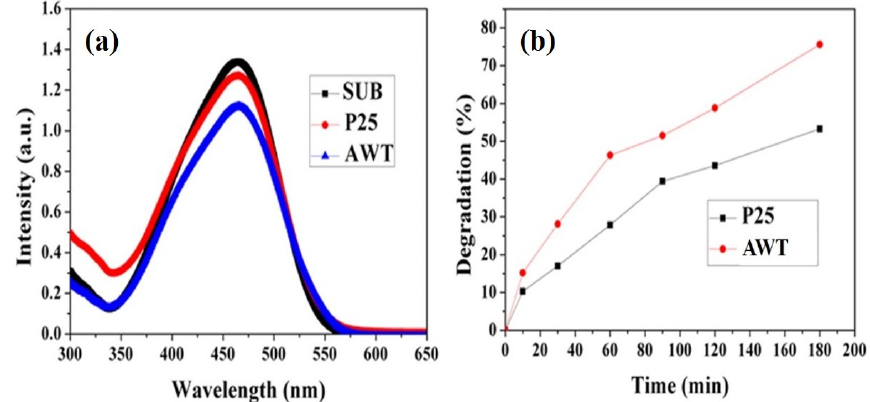
Figure 3. ( a ) UV-Vis adsorption spectra of the P25 and AWT after being stirred in the dark in MO solution for 60 min at room temperature; ( b ) photocatalytic degradation of MO by different photocatalysts under UV light irradiation.